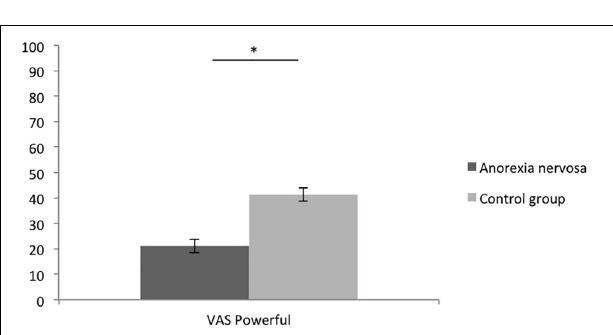
FIGURE 2 | Means of the Visual Analog Scale of Power (VAS) of women with and without AN. Error bars represent SE.